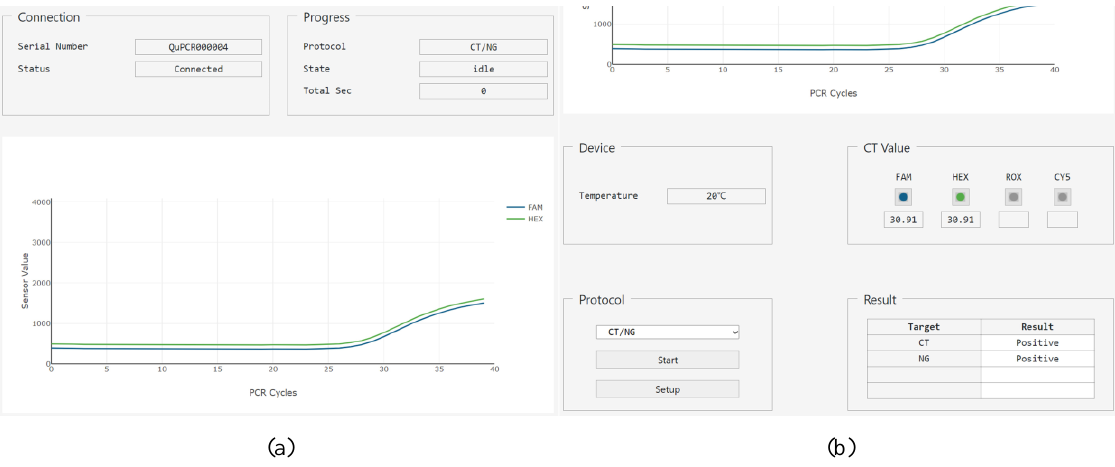
Figure 10. Main page when the protocol has finished. ( a ) The upper part of main page, which shows two bootstrap components and the plot; ( b ) The lower part of main page with the other four bootstrap components.